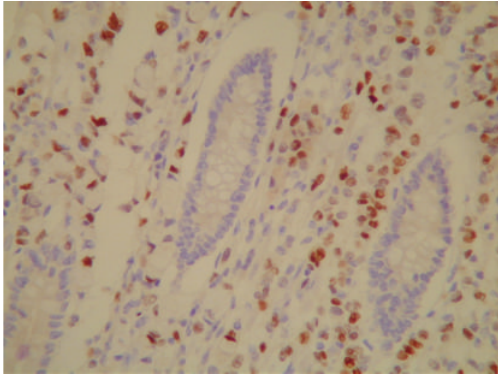
Figure 5: The same slide stained with antibody to estrogen receptor. The malignant cells stain brown (ER clone 6F11, original magnifi- cation ×